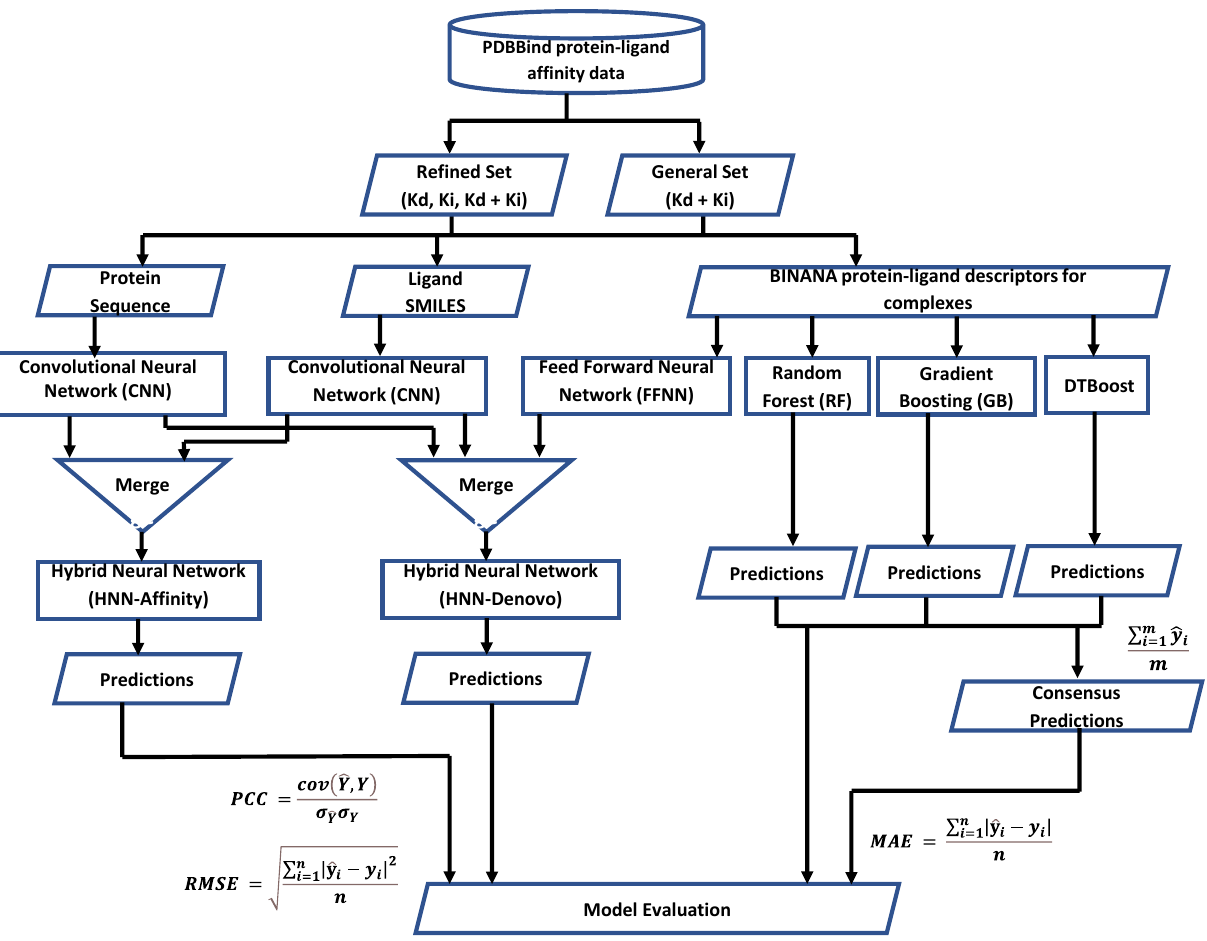
Figure 1. The overall workflow schema of experimental design, the dataset, training, and testing process of the deep learning-based hybrid neural network methods HNN-affinity and HNN-denovo and other machine learning models that we developed in this study.